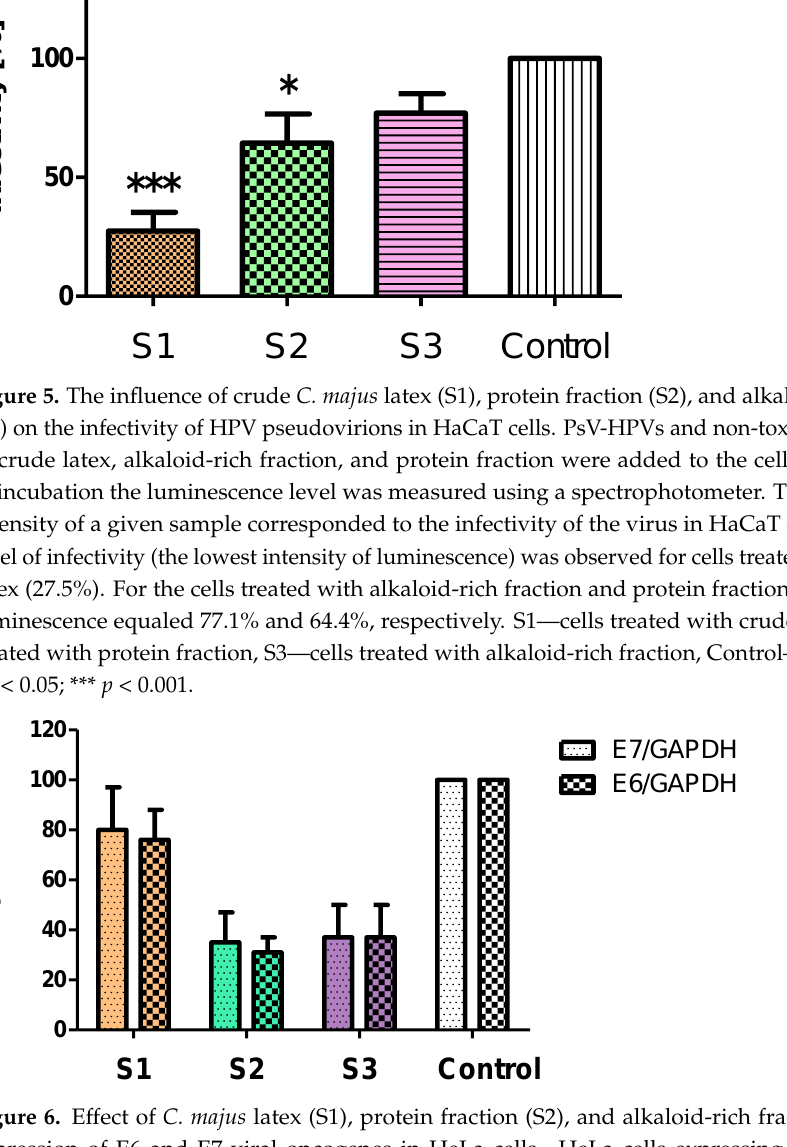
Figure 6. Effect of C. majus latex (S1), protein fraction (S2), and alkaloid-rich fraction (S3) on the expression of E6 and E7 viral oncogenes in HeLa cells. HeLa cells expressing E6 and E7 viral oncogenes were treated with the tested samples. RNA was isolated and transcribed into cDNA, which served as a template in real-time PCR using primers specific for the E6 and E7 genes and the GAPDH which served as reference gene. The lowest level of E6 and E7 transcripts was observed in cells treated with the protein fraction (E6 = 28%, E7 = 24%), was higher in cells treated with the alkaloid-rich fraction (E6 = 37%, E7 = 37%), and was the highest in cells treated with the crude C. majus latex (E6 = 76%, E7 = 80%) compared to untreated cells. S1 — cells treated with crude latex, S2 — cells treated with protein fraction, S3 — cells treated with alkaloid-rich fraction, Control — untreated cells.